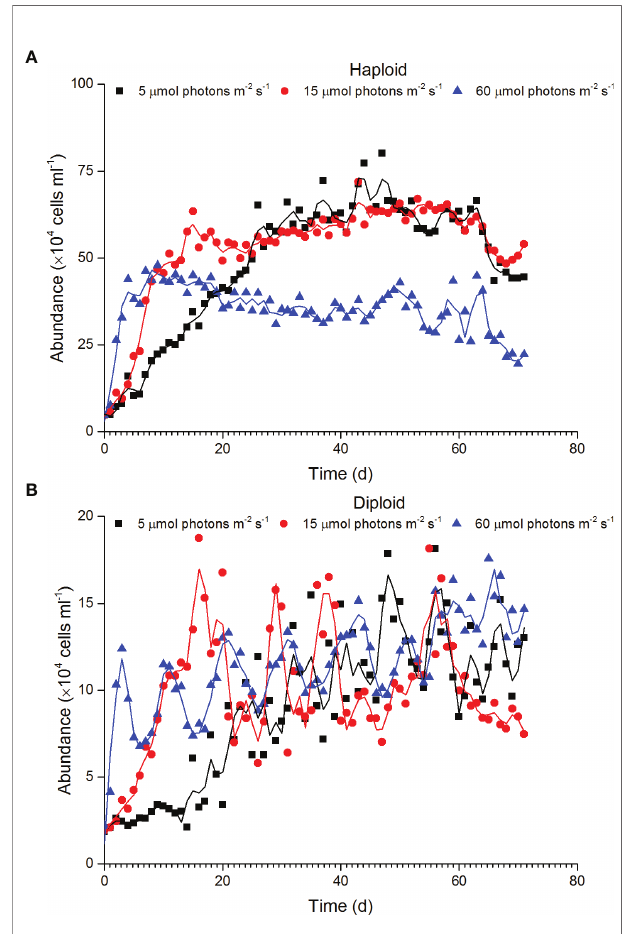
FIGURE 1 | Variation in the abundance of haploid (A) and diploid solitary cells (B) of P. globosa under different low-light